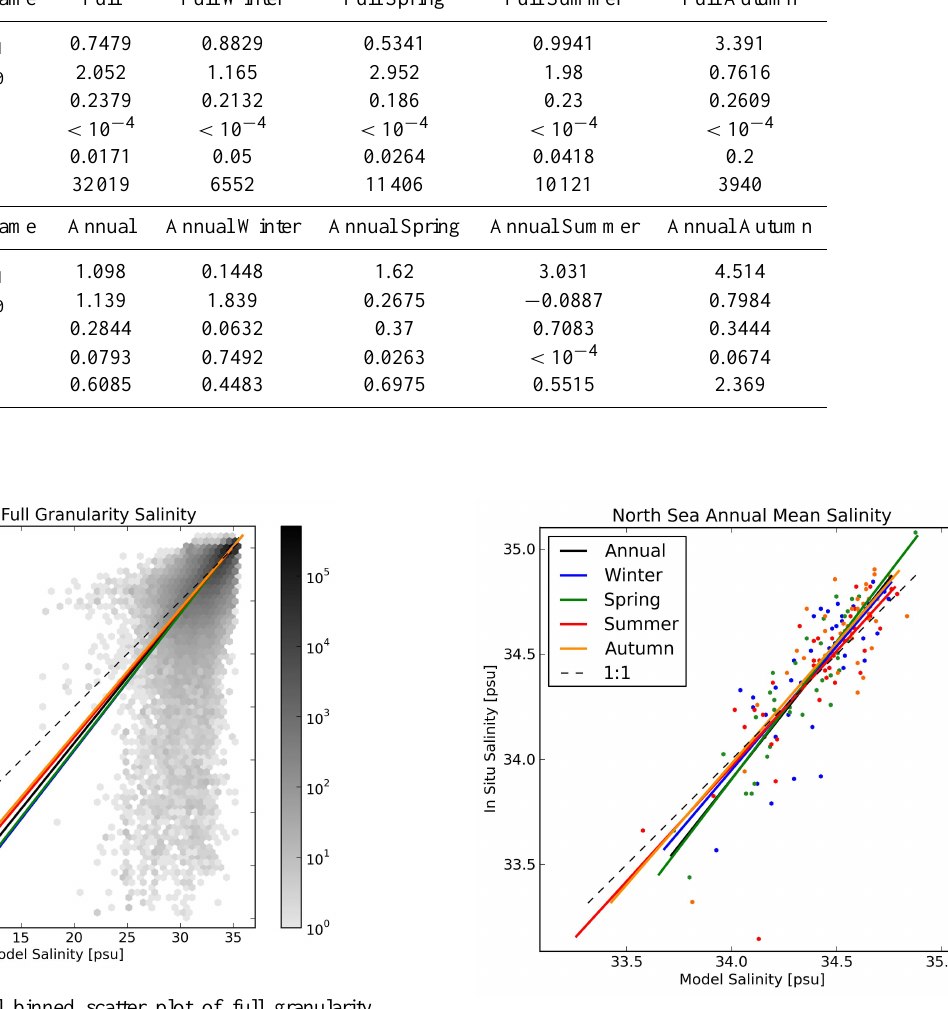
Fig. 5. Two-dimensional scatter plot of annual mean matched model data against in situ measurements for the North Sea salinity. The solid coloured lines show the linear regression fits for the annual and seasonal annual means data, and the dashed line is the line of unity slope that passes through the origin. The matched seasonal means are shown as colour-coded scatter